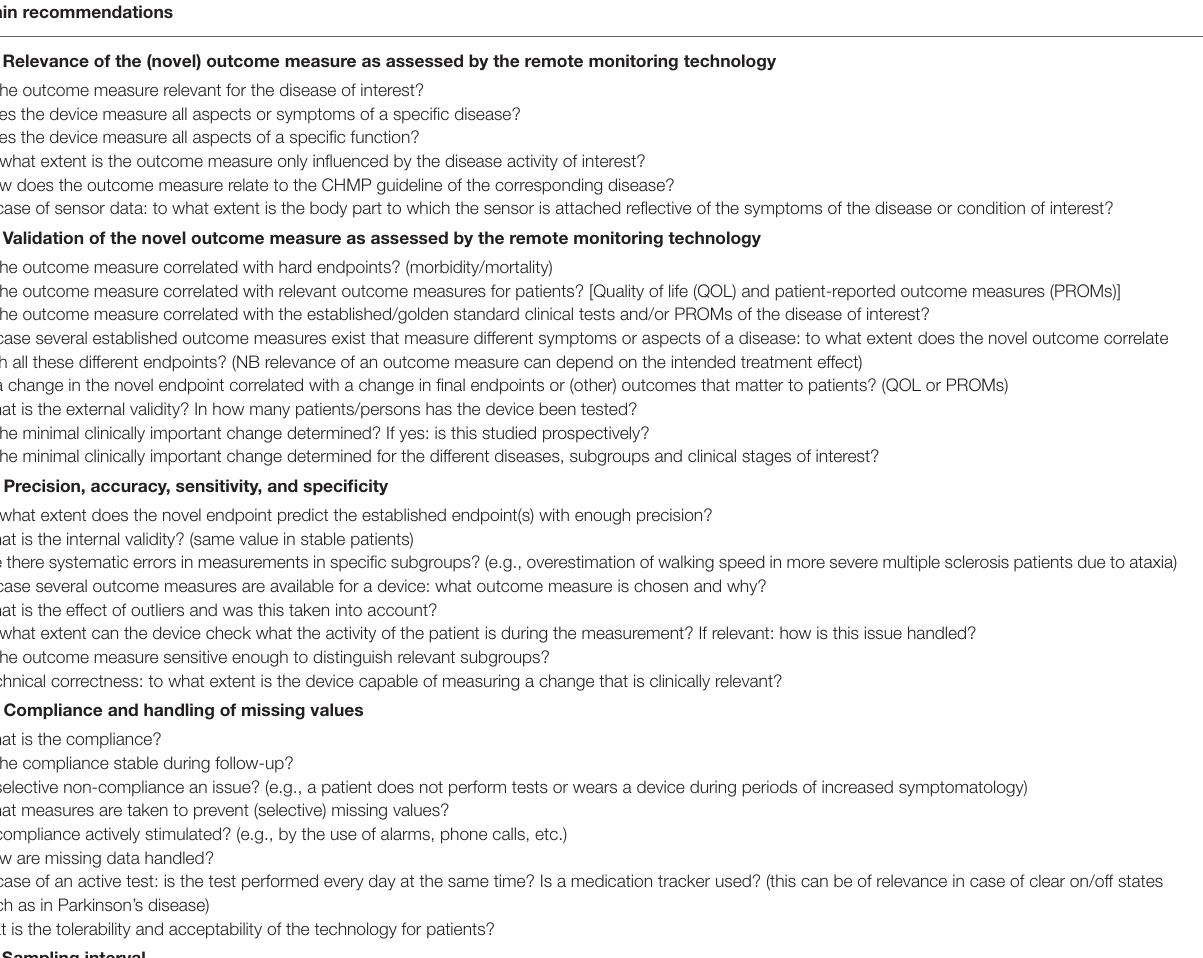
TABLE 2 | Main concerns and questions of the CHMP for the